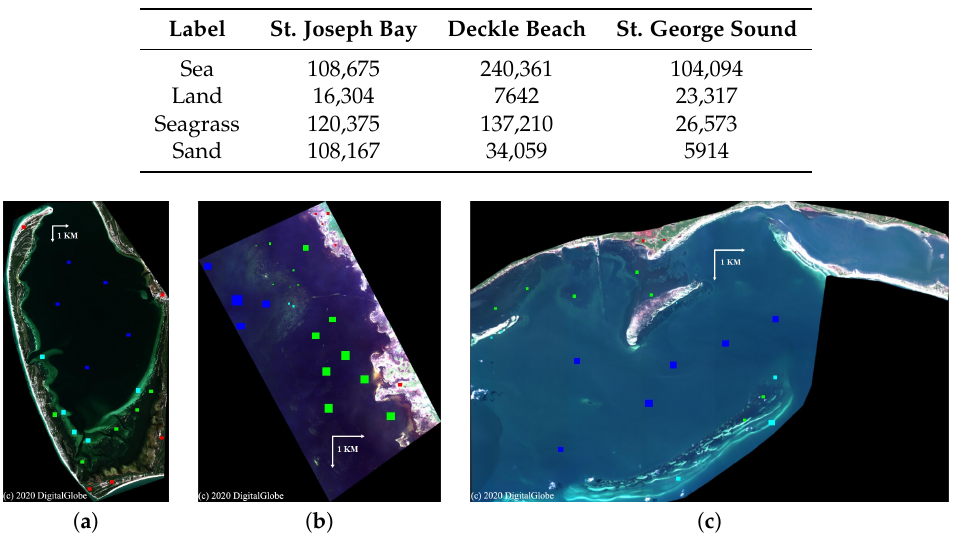
Table 1. Number of patches per class in the selected regions of each satellite image.